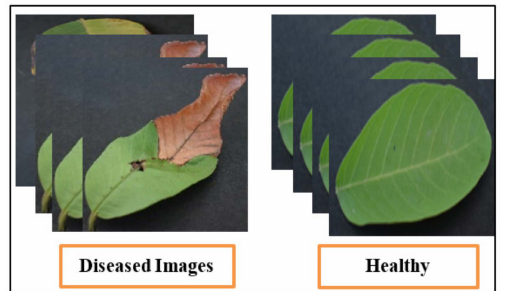
Figure 7. Sample dataset images of guava